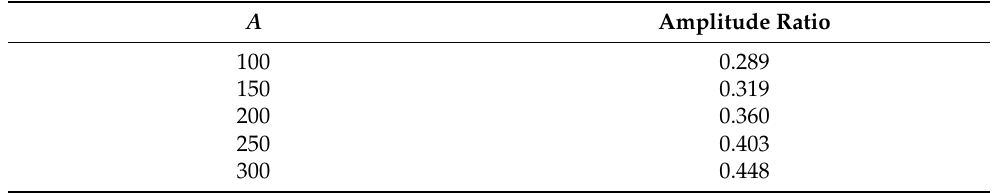
Table 3. Amplitude ratios at different values of A .